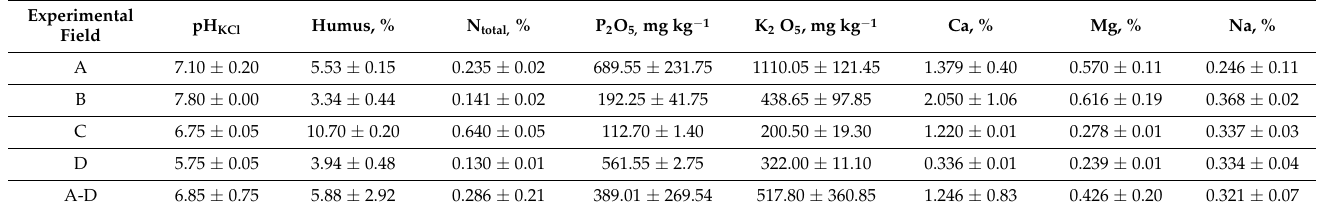
Table 1. Soil chemical properties (means ±